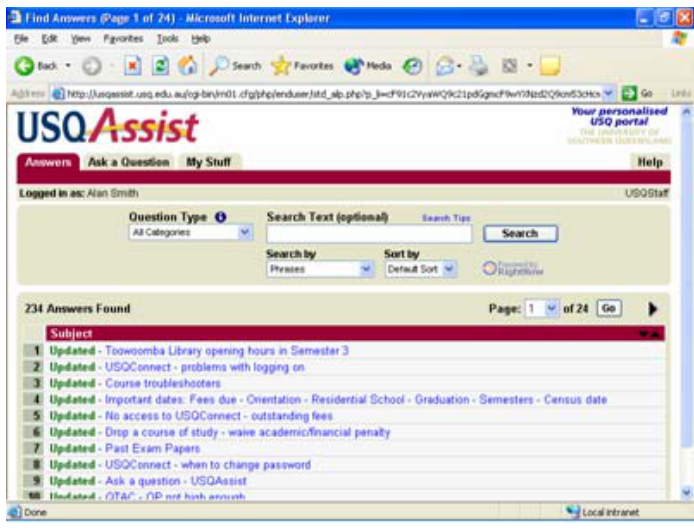
Figure 9. USQ Assist Interface